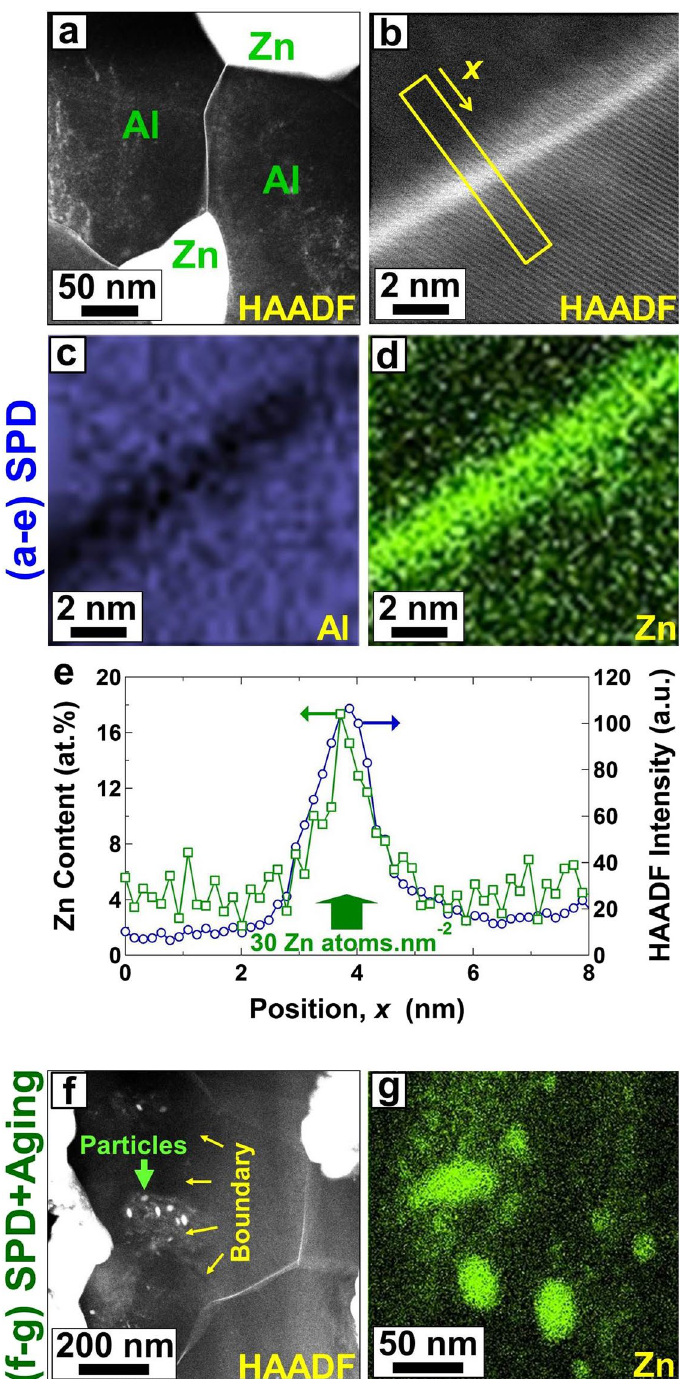
Figure 3. Zn segregates along the Al/Al boundaries after SPD processing, but the Zn-rich boundaries partly transform to Zn precipitates after natural aging. Microstructure of the sample processed by SPD and SPD followed by natural aging. ( a , b ) HAADF images showing the distribution of Al and Zn atoms after SPD processing. Bright and dark contrasts correspond to the Al- and Zn-rich areas, respectively. ( c , d ) EDS mapping for Al and Zn obtained from the HAADF image of ( b ). ( e ) HAADF and EDS line profiles along the direction indicated by an arrow in HAADF image of ( b ). ( f , g ) HAADF image and corresponding EDS mapping for Zn after SPD processing followed by natural aging for 100